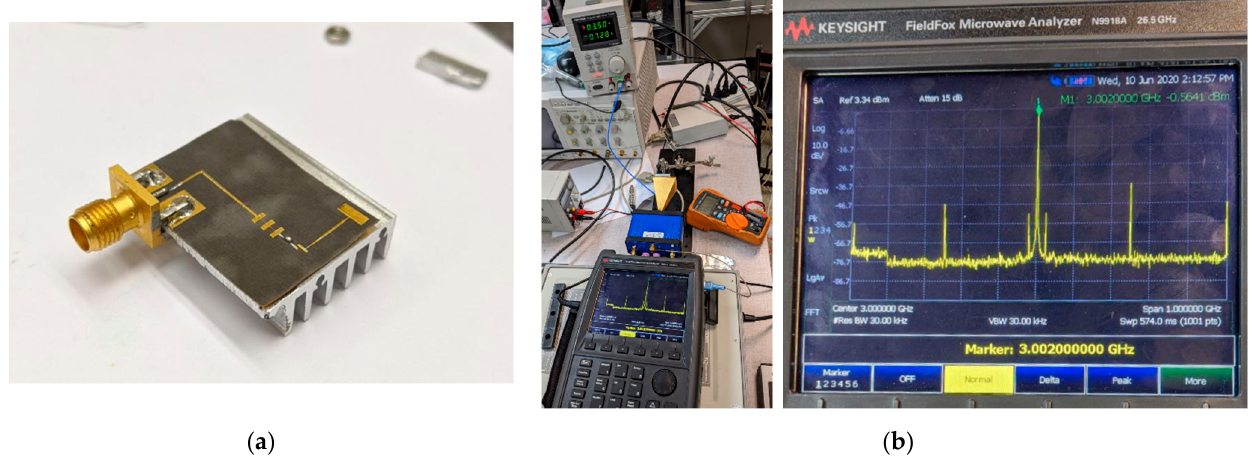
Figure 10. LO signal source PCB ( a ) based on 55 GHz Microsemi GaAs Gunn and source measurement stand with the measured 3.002 GHz peak, corresponding to 13.0 GHz × 4 + 3.002 GHz = 55.002 GHz source frequency ( b ).